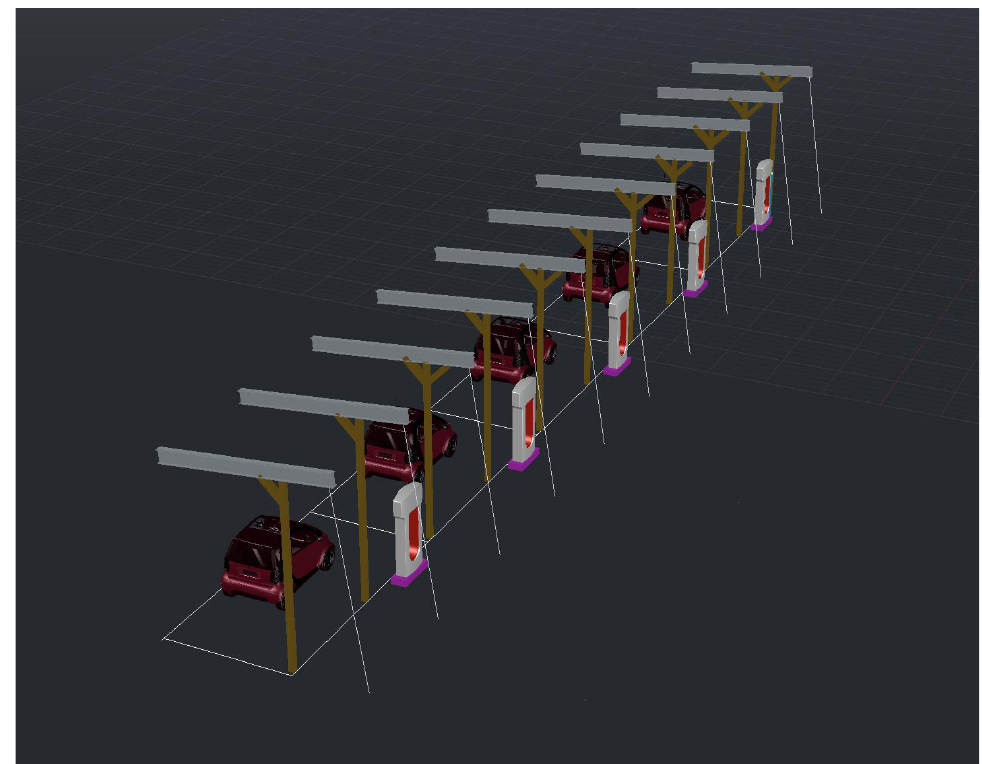
Figure 9. Aluminum beams installed onto 8 × 8 posts angled at five degrees and supported with ¼″ 7 × 19 strand galvanized aircraft cable and diagonal bracing. Then, 2 × 10 joists are then installed horizontally across the aluminum beams. Splice joints are to be made at 20% of the span length away from each beam. H1 hurricane ties with self-tapping screws are used to connect the ties to the beam, and joist hanger nails are used to connect the ties to the wood. Then, 1 m long lateral braces are installed between each beam. The final cantilevered system is shown in Figure 10. The cables are anchored in the road verge, which is normally a strip of grass located between a roadway (carriage- way) and a sidewalk (pavement). This curbside system provides the potential for PV can- opies on the sides of streets with only street parking to charge EVs. Substantial future work is needed to investigate the regulatory and legal ramifications of such systems, as the road verge and street are normally owned by the municipality.